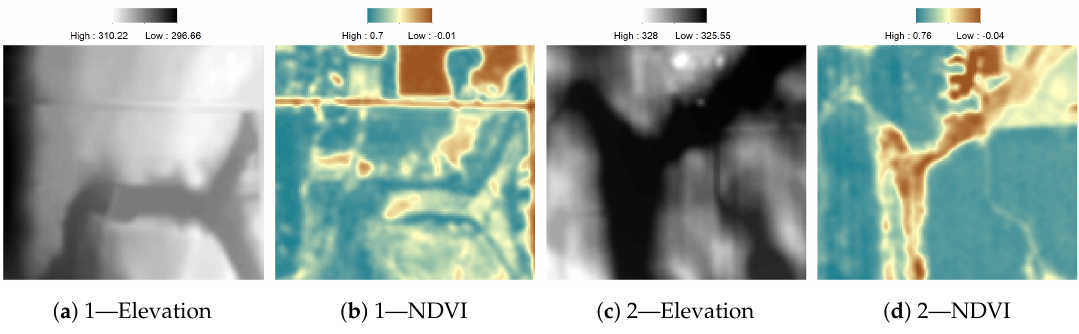
Figure 15. DEM and NDVI values from depression study areas.